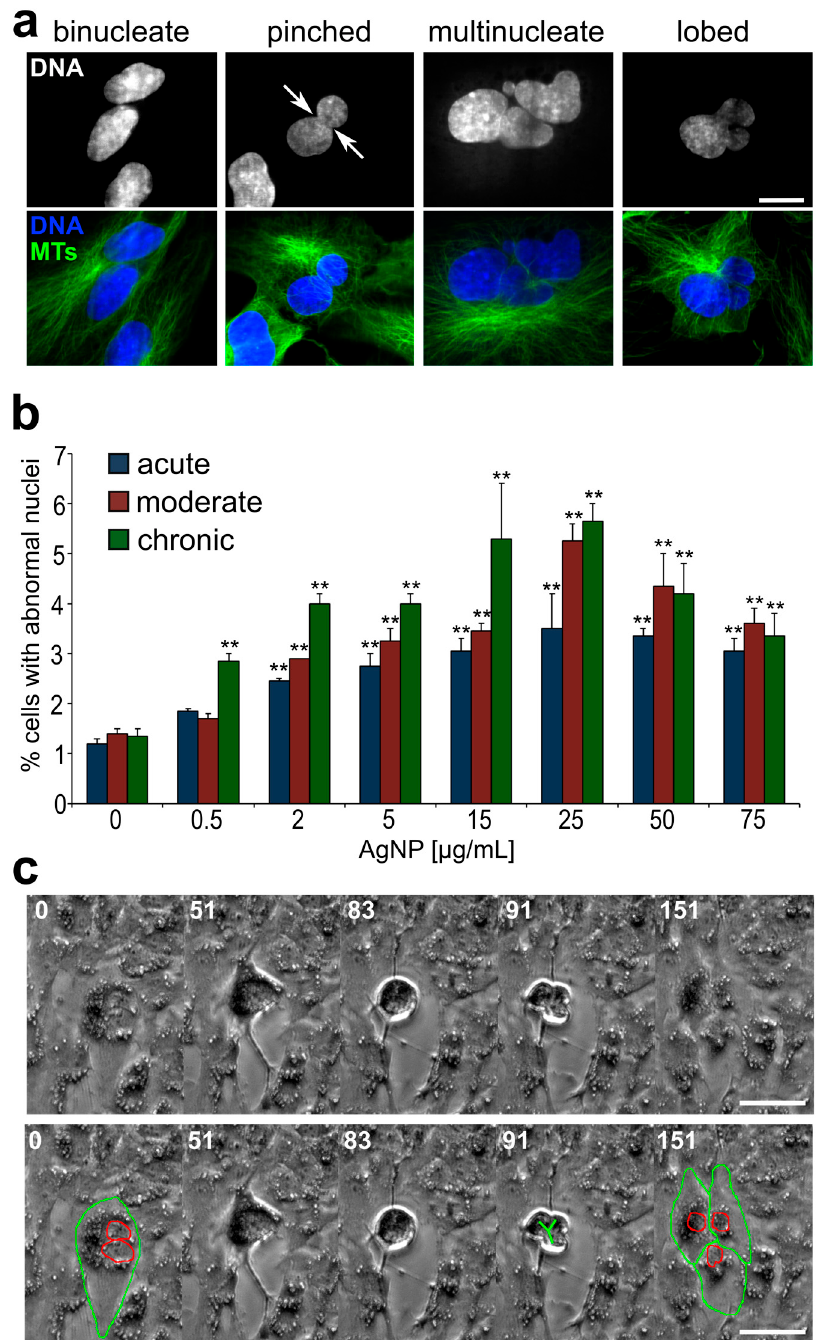
Figure 8. Increased frequencies of cells with large, abnormally shaped nuclei in AgNP-treated cell populations. ( a ) Example images of abnormal nuclear phenotypes quantified in this study. Images in the top row display DNA staining, whereas an overlay of DNA (blue) and microtubule (MTs, green ) staining is shown in the bottom row. Scale bar, 10 µ m. ( b ) Frequencies of cells with abnormal nuclear phenotypes following acute, moderate, or chronic AgNP exposure. **Fisher’s exact test, p < 0.005. ( c ) Still frames from time-lapse microscopy video recorded during the last treatment of a moderate exposure regime and showing a binucleate cell (highlighted in bottom panel) undergoing tripolar division (see also additional file 4), resulting in three daughter cells (highlighted in bottom panel). Numbers indicate elapsed time in min; Scale bar, 10 µm.